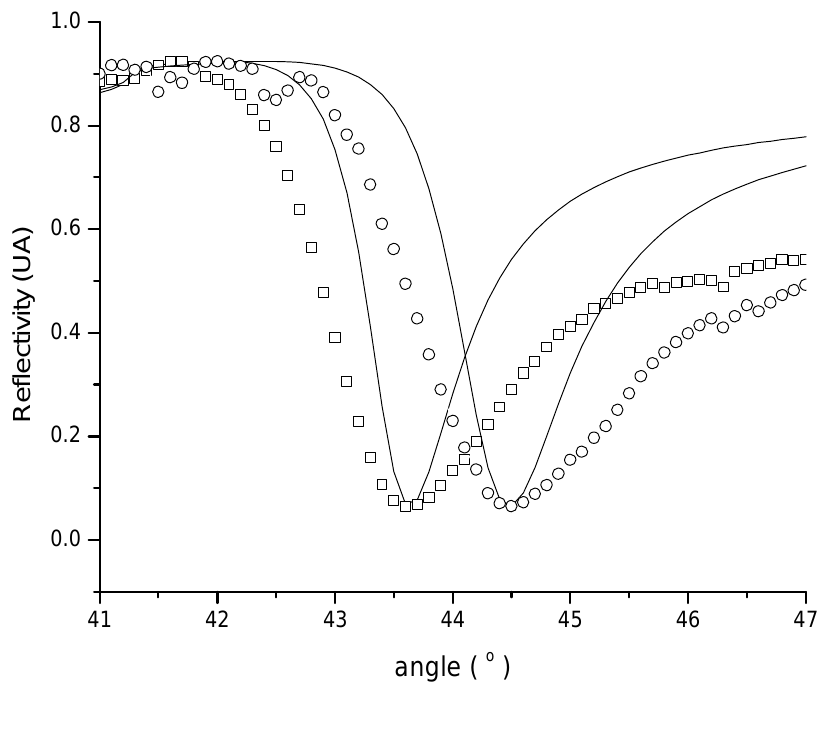
Figure 1. SPR spectra for a gold film of 52.4 nm measured thickness (squares), and after deposition of a 7.1 nm polyethylene film (circles). Lines correspond to the theoretical model (See Ref.